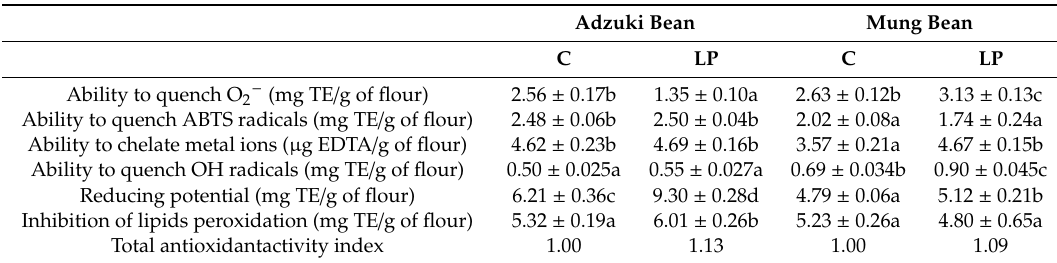
Table 2. Antioxidant capacity the fraction obtained after simulated gastric digestion of the control and probiotic-rich adzuki bean